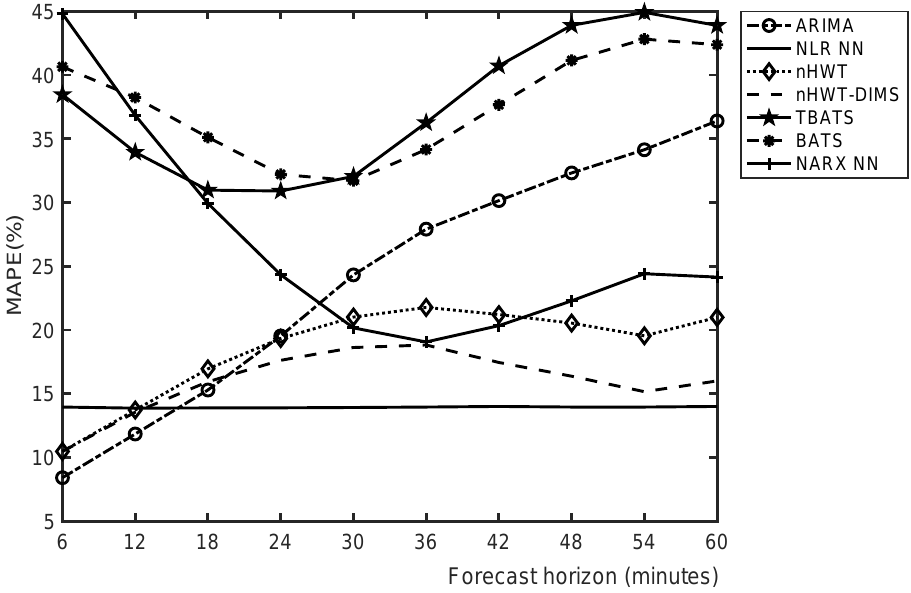
Figure 13. Mean absolute percentage error (MAPE) comparison of one hour-ahead forecasts.